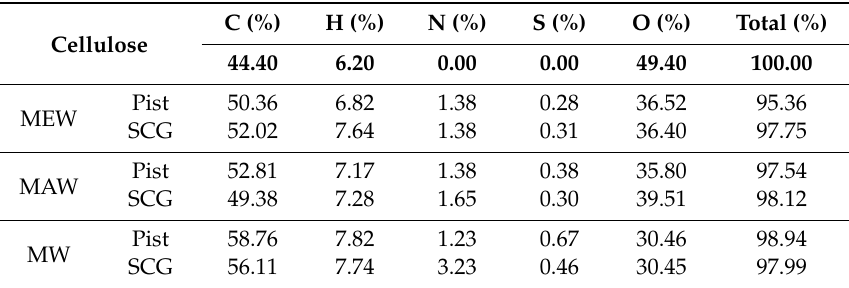
Figure 9. Solid state Nuclear Magnetic Resonance ( ssNMR) 13 C, 1 H spectra for MEW samples. Table 6. Elemental analysis of CEF. The column denominated “Total” corresponds to the sum of the analyzed elements.